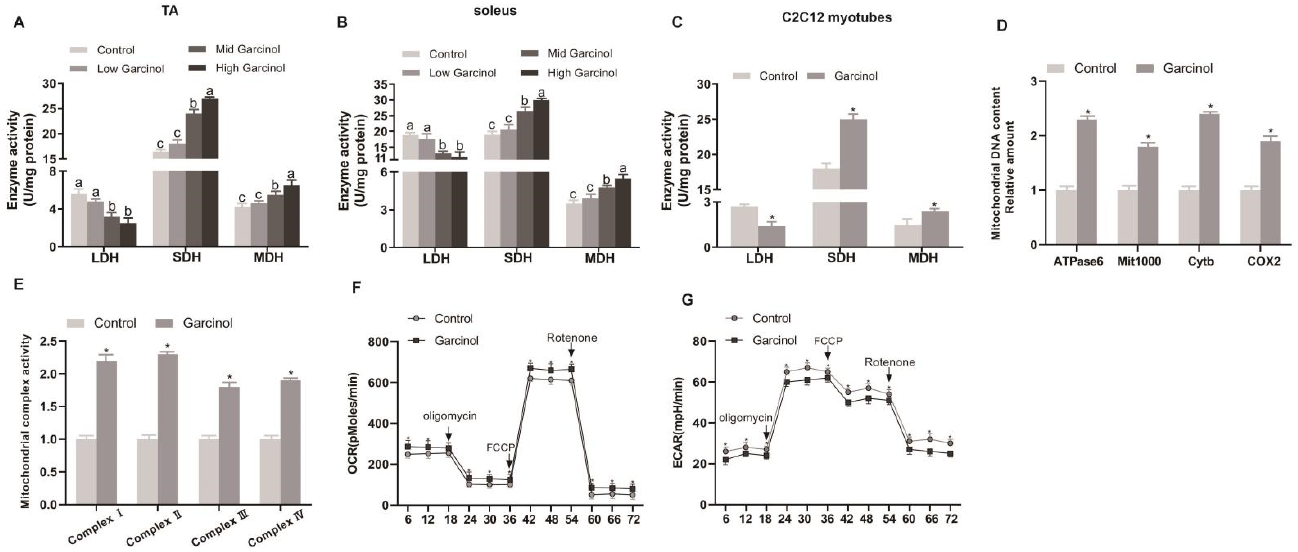
Figure 4. Effects of dietary garcinol on the activity of lactate dehydrogenase (LDH), succinic dehydrogenase (SDH), and malate dehydrogenase (MDH) in TA ( A ), soleus ( B ) muscle of mice and C2C12 myotubes ( C ), respectively. ( D , E ) Quantification of mitochondrial DNA contents and complex activity. ( F , G ) Effect of garcinol on oxygen consumption rate and extracellular acidification rate. Data are shown as the mean ± SE, n = 10. * Different from the control group, p < 0.05. Means without a common letter differ, p < 0.05.